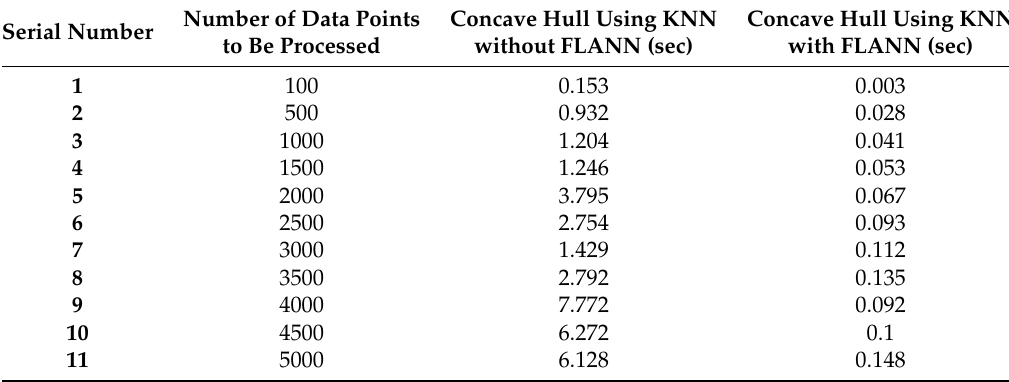
Table 5. Execution Time comparison; concave hull using K-Nearest Neighbours (KNN) without Fast Library for Approximate Nearest Neighbours (FLANN) vs. concave hull using KNN with